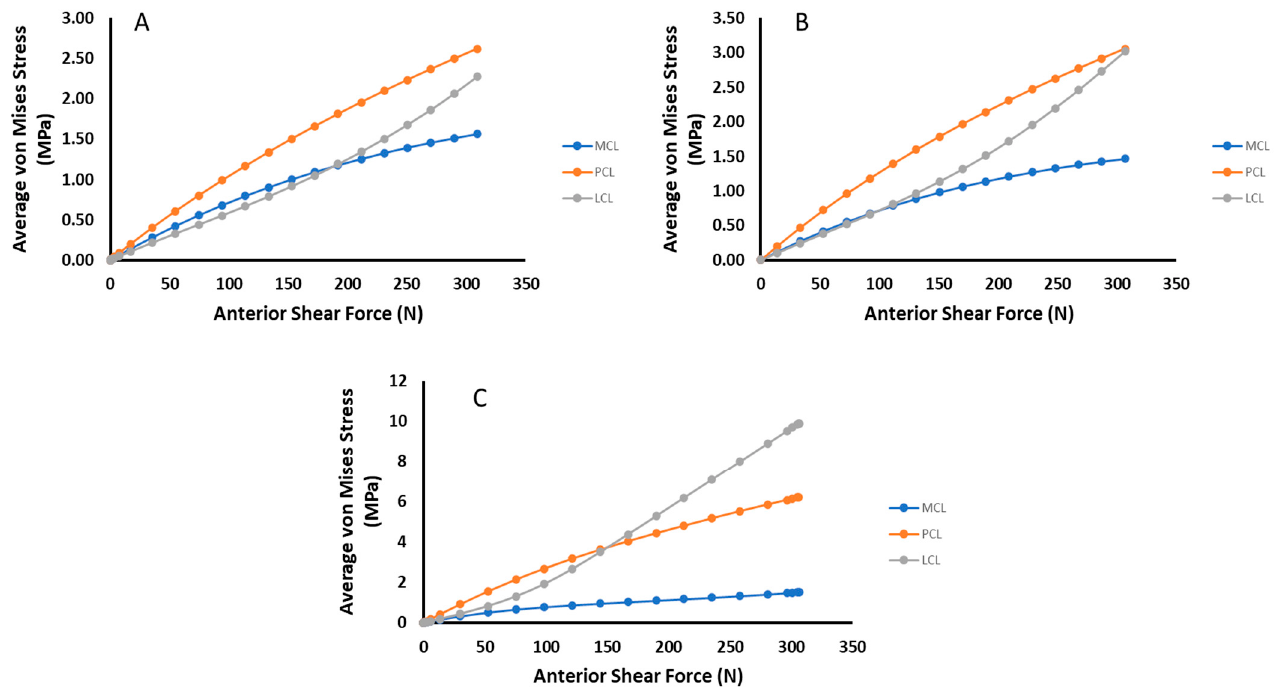
Figure 12. Comparative plots of the relative stress amounts for each ligament for each damage state under anterior shear loading. ( A ) no damage ( B ) 2000 N Damage ( C ) ACL Removed.